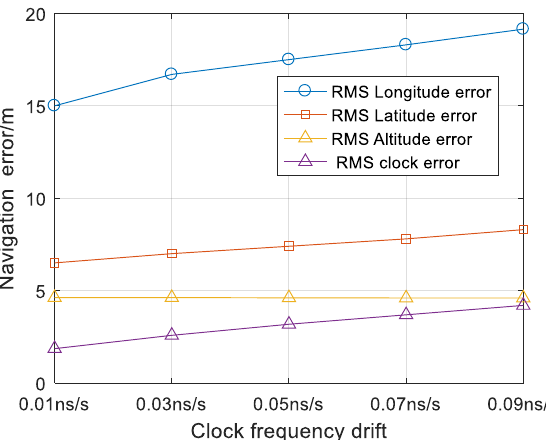
Figure 16. RMS error comparison of member 6 between different clock frequency